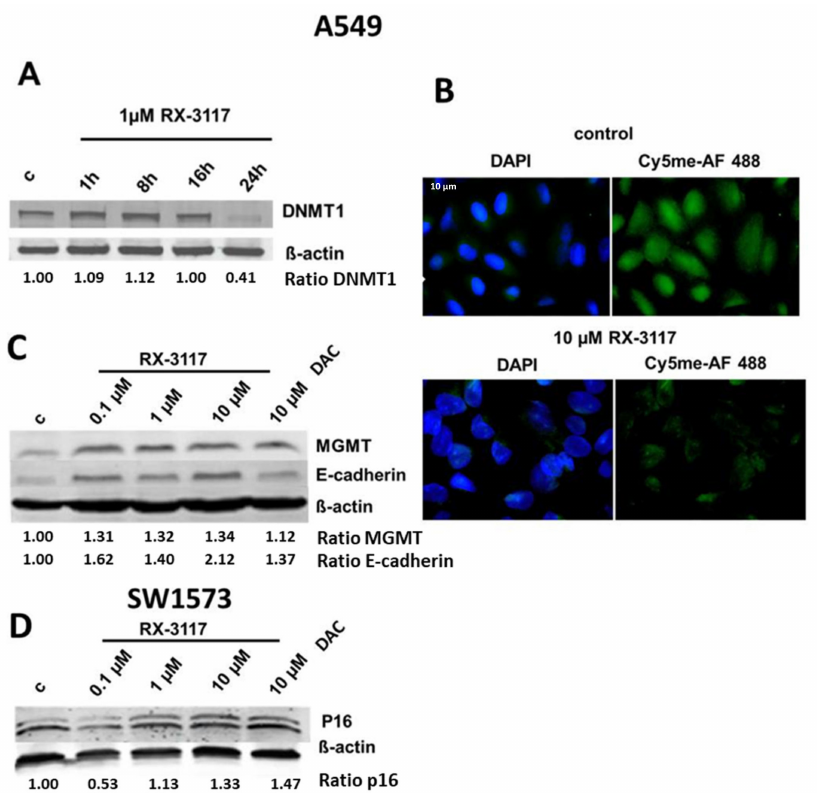
Figure 2. The e ff ect of RX-3117 mediated DNMT1 down-regulation on DNA methylation and expression of target proteins (ratio to β -actin) in A549 and SW1573 NSCLC cells. A : Time dependency of DNMT1 down-regulation. Western blot analysis of cell lysates after exposure to 1 µ M RX-3117 after 1, 8, 16, and 24 h; β -actin was an internal loading control. B : Confocal microscopy pictures of A549 cells stained for the nucleus with DAPI (blue) and for total DNA methylation with 5mC Alexa Fluor-488 (green). The upper panel shows a control of untreated cells, the lower panel shows cells treated for 24 h with 10 µ